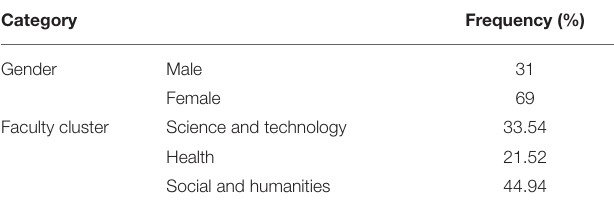
TABLE 1 | Respondents’ demographic data. TABLE 2 | Work values instruments.